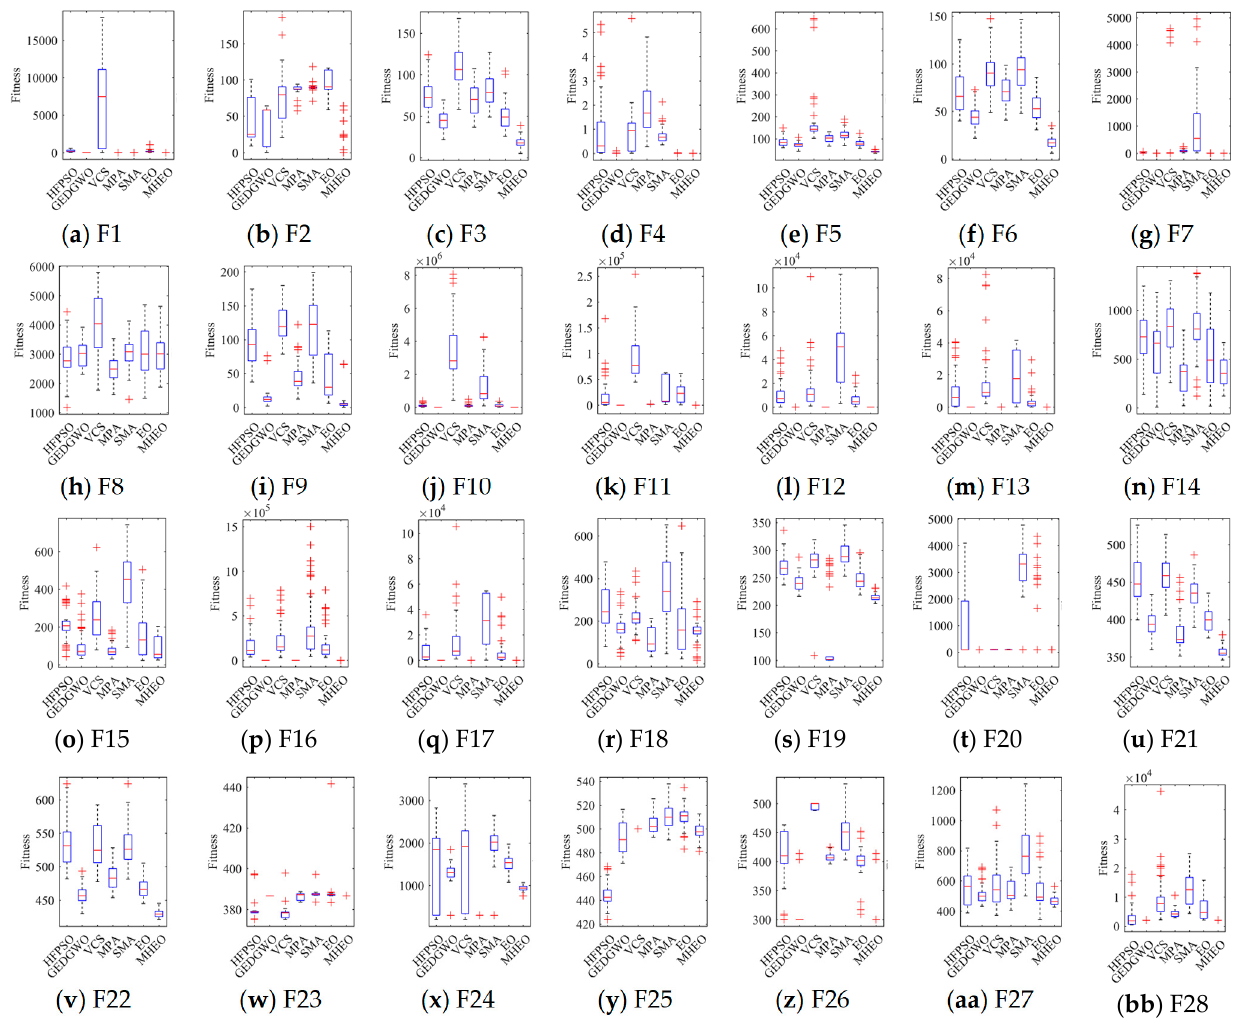
Figure 2. Boxes diagram of CEC2017. Subfigures a-bb represent functions F1–F28 respectively .